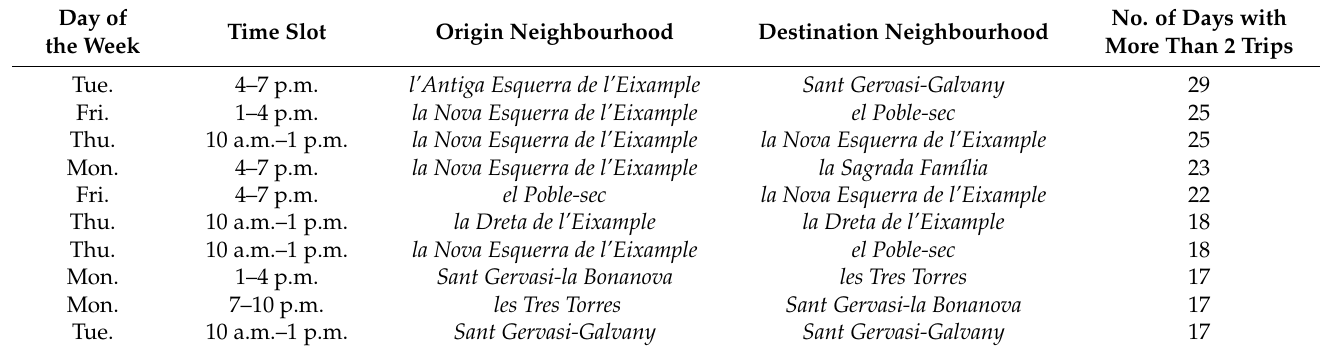
Table 4. Most frequent trips between neighbourhoods per day of the week and time slot, ordered by the number of days with more than λ = 2 trips performed in the same time